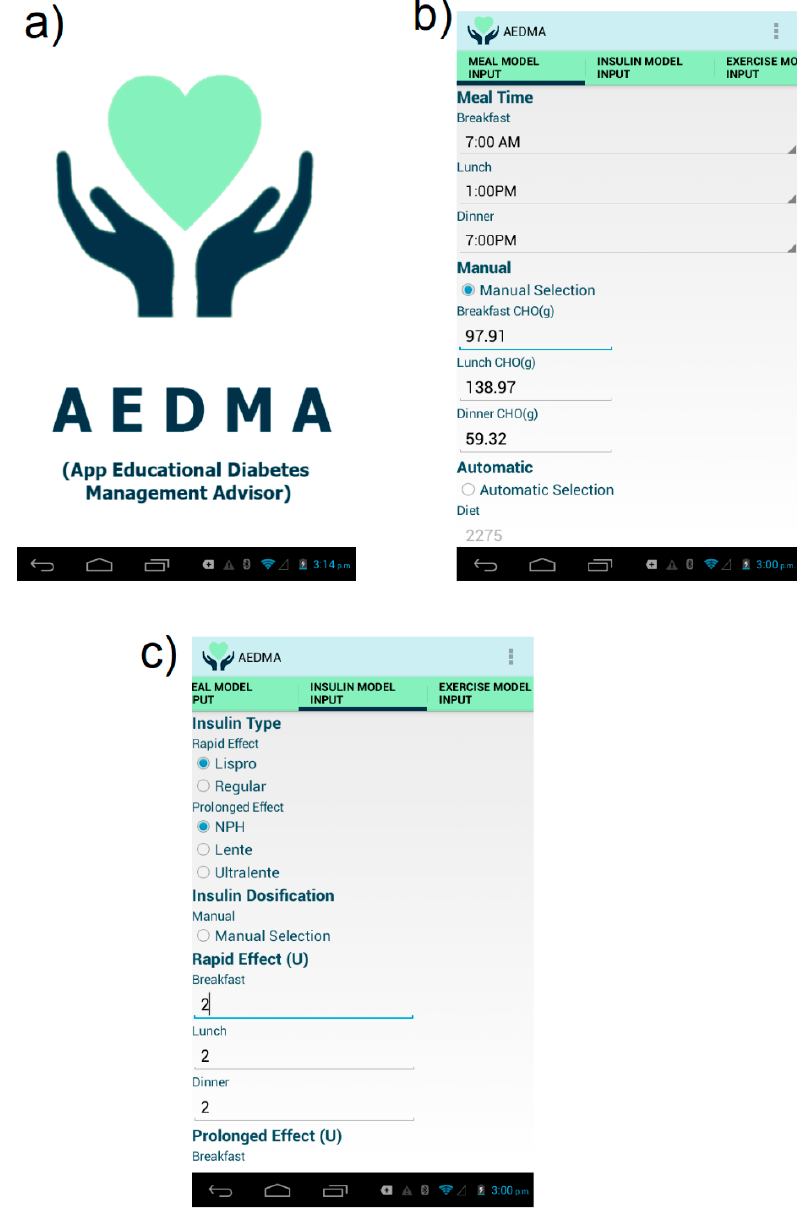
Figure 3. Screens of the proposed AEDMA app. ( a ) Main screen of the proposed applications. ( b ) Components of the meal model input Table. ( c ) Components of the insulin model tab.